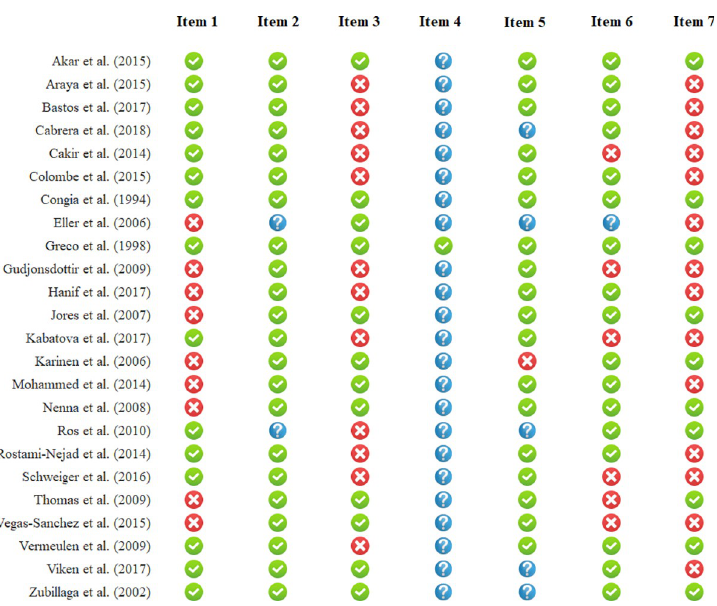
Fig 6. Summary of risk of bias in individual studies included in meta-analysis. Green, red, and blue icons represent low, high, and uncertain risk of bias. Definitions of items are provided in S1 Table.